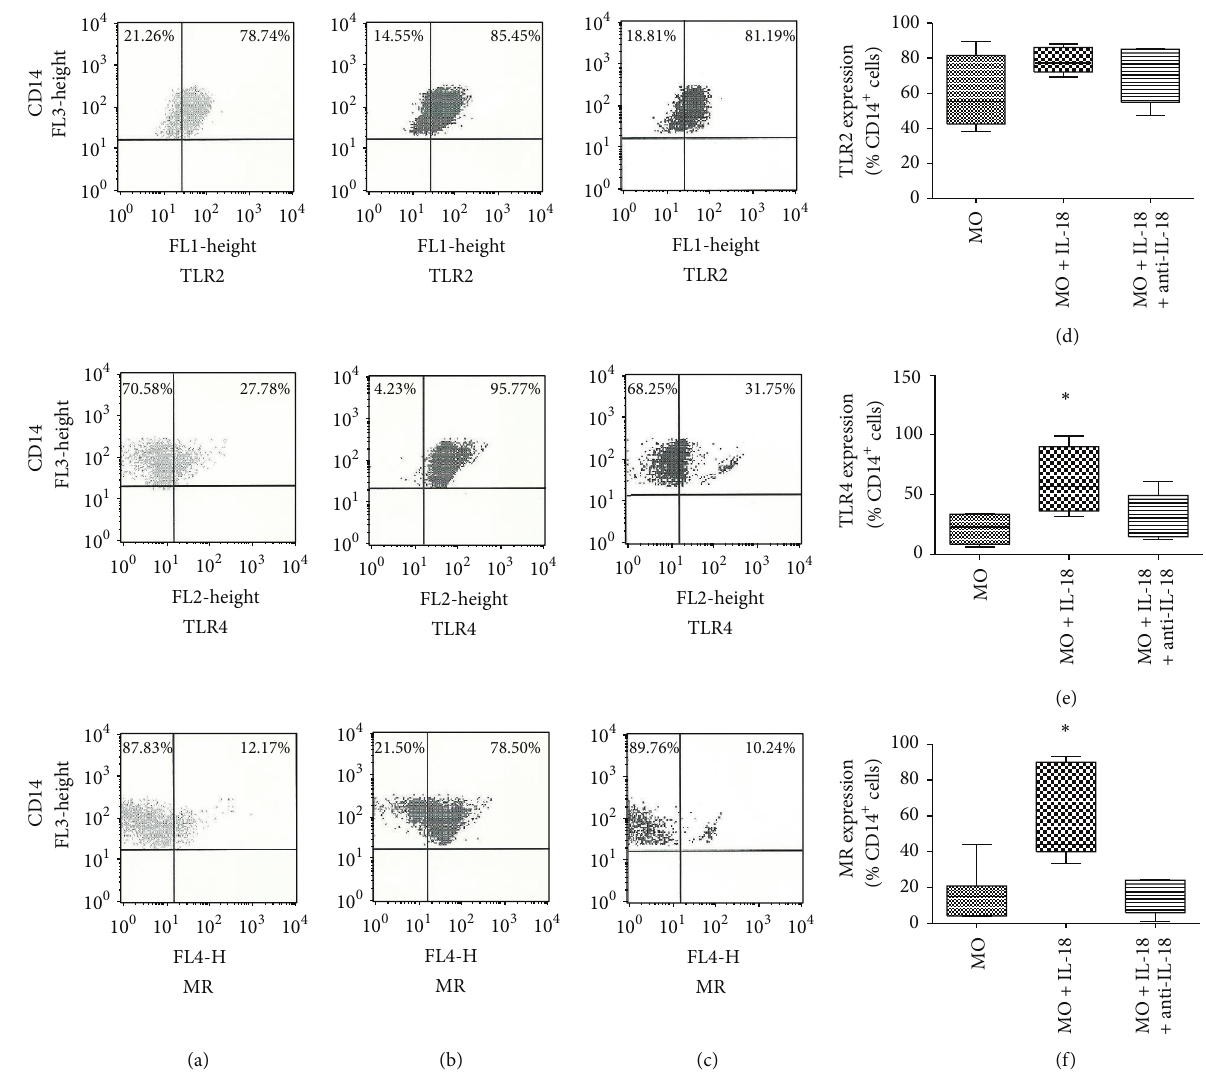
Figure 1: TLR2, TLR4 and MR expression in CD14 + monocytes. CD14 + monocytes (column (a)) were treated with IL-18 (100ng/mL) (column (b)), or IL-18 (100ng/mL) plus anti-IL-18 (0,5 𝜇 g/mL) (column (c)), for 18 hours and evaluated by flow cytometry. Box-and-whisker plot showing data distribution of 15 healthy subjects tested for TLR2 (d), TLR4 (e), and MR (f). Horizontal lines represent the median values; boxes represent the 25th to 75th percentiles and vertical lines the 10th to 90th percentiles. ∗ Statistical significance between groups is indicated ( 𝑃 < 0.05 × other